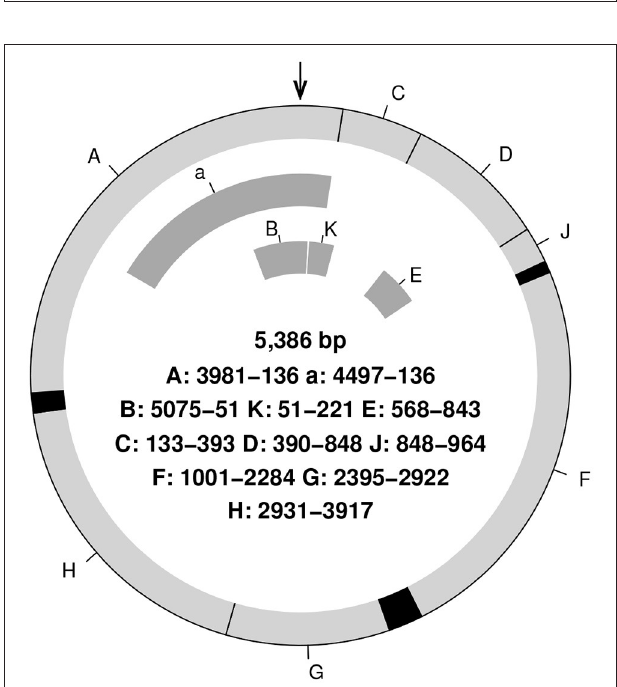
FIGURE 2 | A schematic genome structure and gene sizes of phiX174. There are 11 genes, and black regions are intergenic spacers. The arrow indicates the origin. Note that there is a 4-base overlap between genes A and